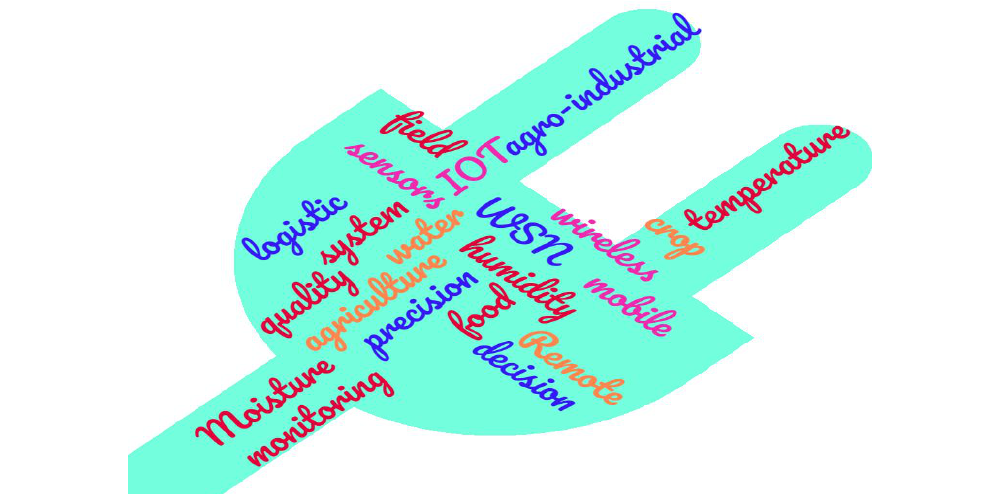
Figure 16. Word cloud for “Wireless sensor networks for agriculture: The state-of-the-art in practice and future challenges”.